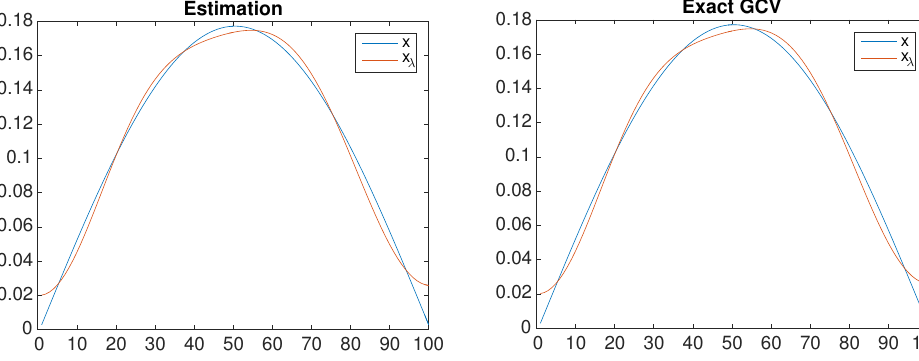
Figure 3. Solution of the Baart test problem via an estimation of GCV ( left ) and the exact GCV ( right